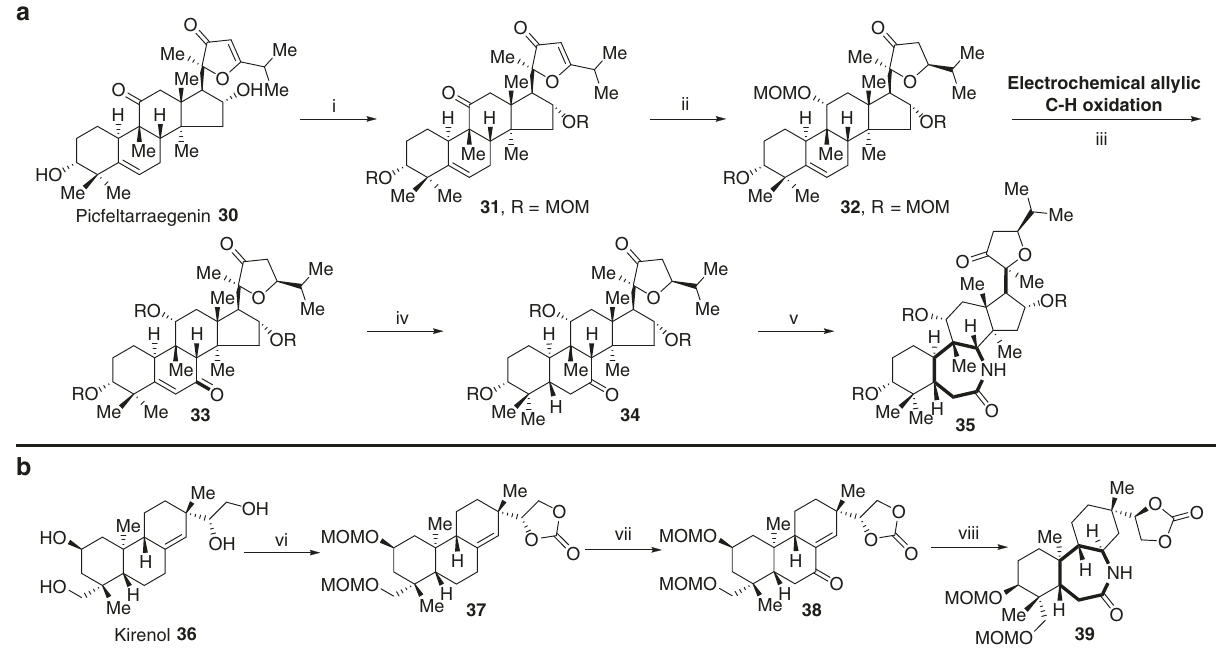
Fig. 4 Application of the two-phase C – H oxidation/ring expansion strategy to picfeltarraegenin and kirenol. a Electrochemical allylic C – H oxidation/ring expansion of picfeltarraegenin. b Allylic C – H oxidation/ring expansion of kirenol. (i) MOMCl, DIPEA, DMAP, CH 2 Cl 2 , rt; (ii) (a) NaBH 4 , EtOH, rt, (b) MOMCl, DIPEA, DMAP, CH 2 Cl 2 , 50 °C; (iii) LiClO 4 , Py, t- BuOOH, Cl 4 NHPI, acetone, rt. (iv) Pd/C, H 2 , MeOH, rt; (v) NH 2 OH (cid:129) HCl, KOAc, (c) TsCl, DMAP, Py, 60 °C; (vi) (a) CDI, toluene, 90 °C, (b) MOMCl, DIPEA, DMAP, CH 2 Cl 2 , rt; (vii) (a) SeO 2 , dioxane, (b) (COCl) 2 , DMSO, Et 3 N, CH 2 Cl 2 ; (viii) (a) Pd/C, H 2 , EtOAc, (b) NH 2 OH (cid:129) HCl, KOAc, 70 °C, (c) TsCl, DMAP, Py, 60 °C. Full details are in Supplementary Figure